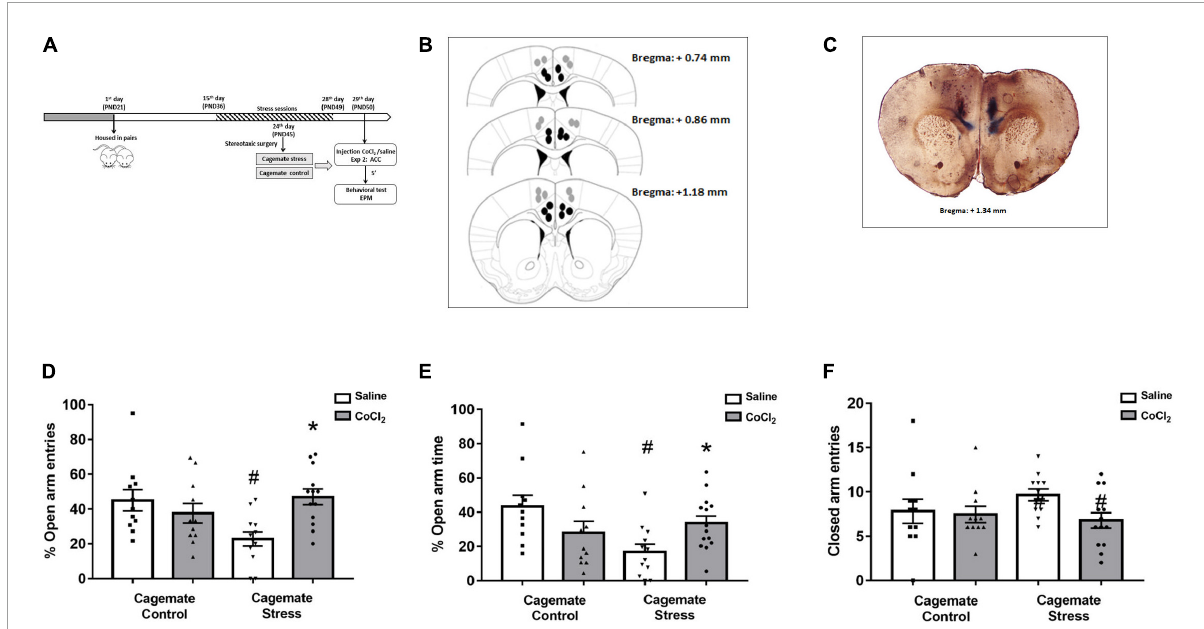
FIGURE2 (A) Schematic representation of the experimental protocol (PND, postnatal day). (B) Schematic representation and (C) photomicrographs of histological results according to the Atlas of Paxinos and Franklin (2019) in the anterior cingulate cortex (ACC). The black circles represent the sites of drug infusion that were on-target within the ACC. The gray circles represent the locations in which the injection occurred outside the ACC. The number of dots in the panel is fewer than the number of animals used because of data overlapping (Bregma: +1.34 mm). (D) Effects of microinjection in the ACC of saline or CoCl 2 (1 mM.100 nL - 1 ) in cagemates that cohabited in pairs with mice subjected to chronic restraint stress evaluated on the percentage of entry into the open arms in the EPM. (E) Effects of microinjection in the ACC of saline or CoCl 2 (1 mM.100 nL - 1 ) in cagemates that cohabited in pairs with mice subjected to chronic restraint stress evaluated on the percentage of time in open arms in the EPM. (F) Effects of microinjection in the ACC of saline or CoCl 2 (1 mM.100 nL - 1 ) in cagemates that cohabited in pairs with mice subjected to chronic restraint stress evaluated on the entry into the closed arms in the EPM. ACC, anterior cingulate cortex. All data are presented as mean ± SEM ( n = 11–13). # p < 0.05 vs. respective cagemate control. * p < 0.05 vs. respective saline group. Two-way ANOVA, followed by Duncan post-hoc